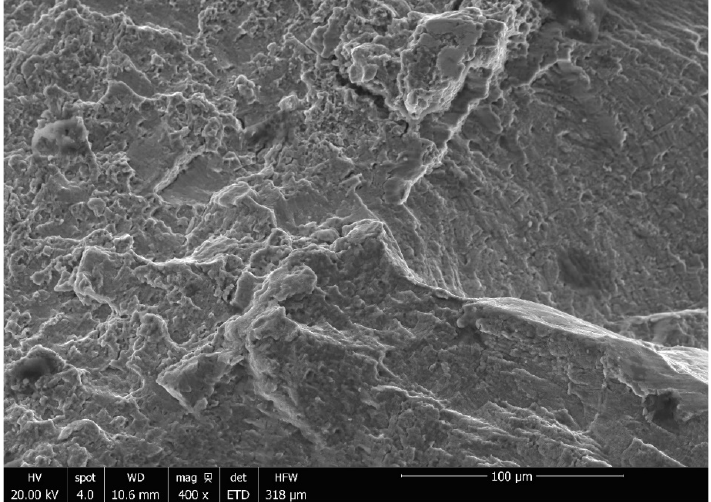
Figure 14. Topographical SEM image of the fracture split area.